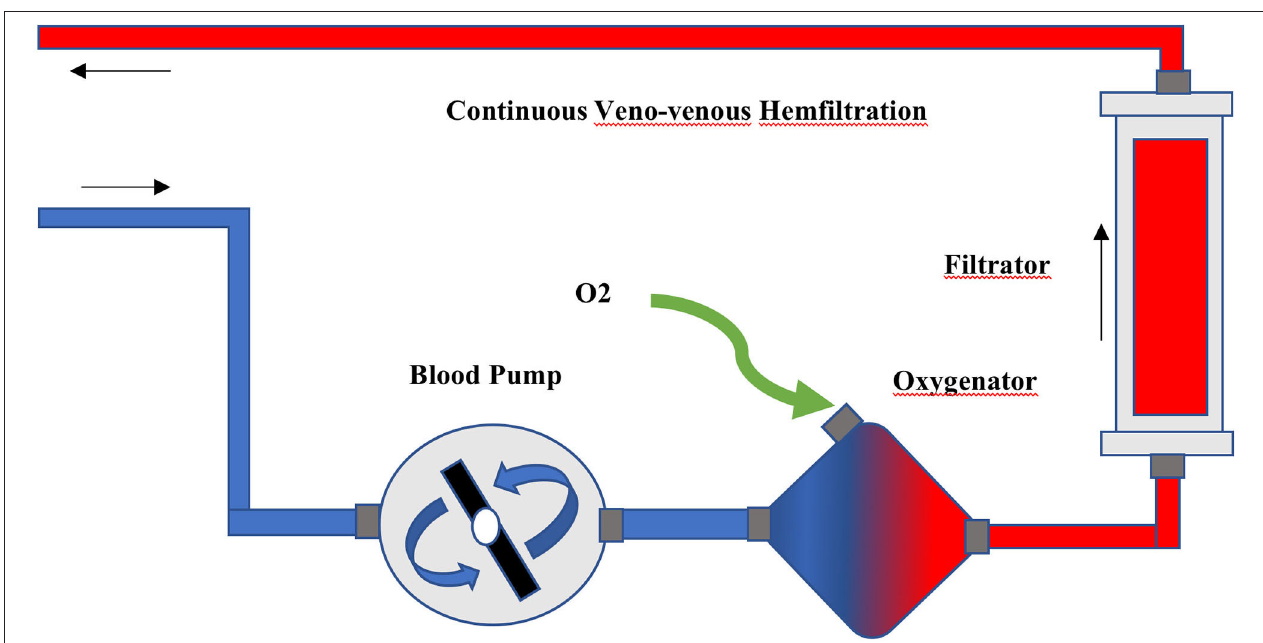
FIGURE 1 | The connection of hemofiltration and extracorporeal